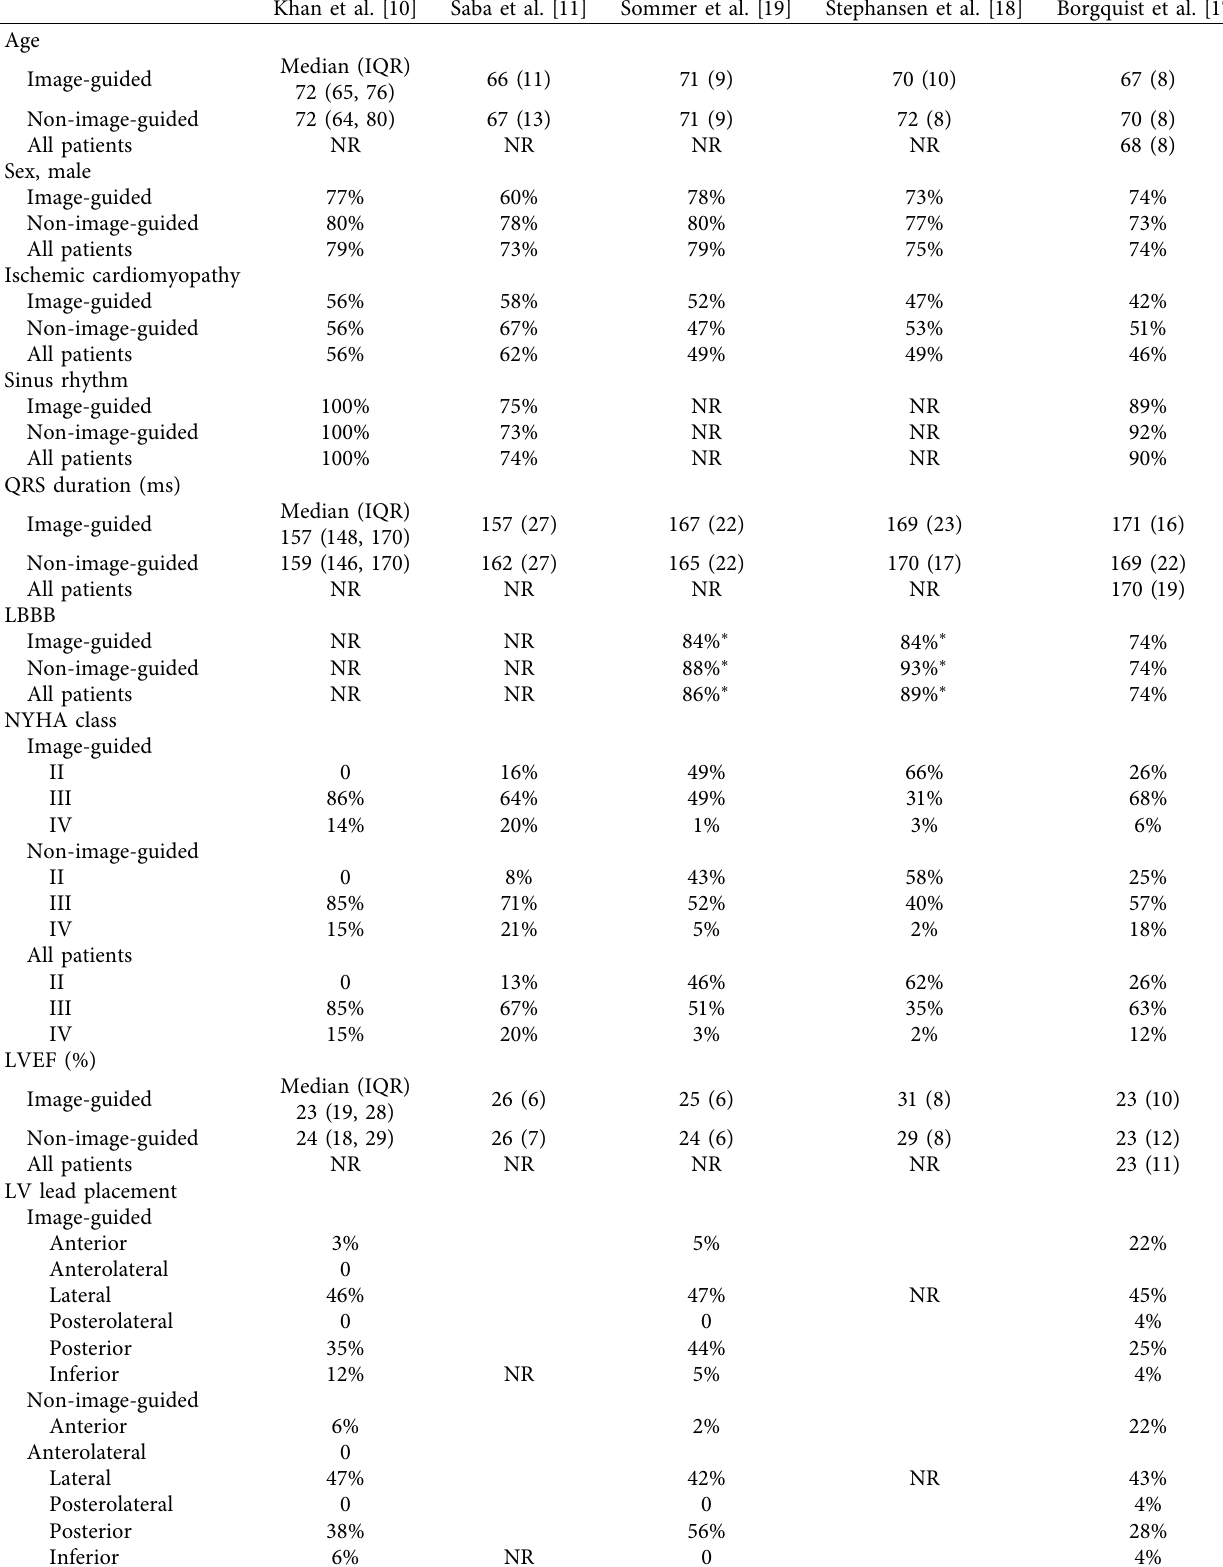
Table 2: Summary of patient